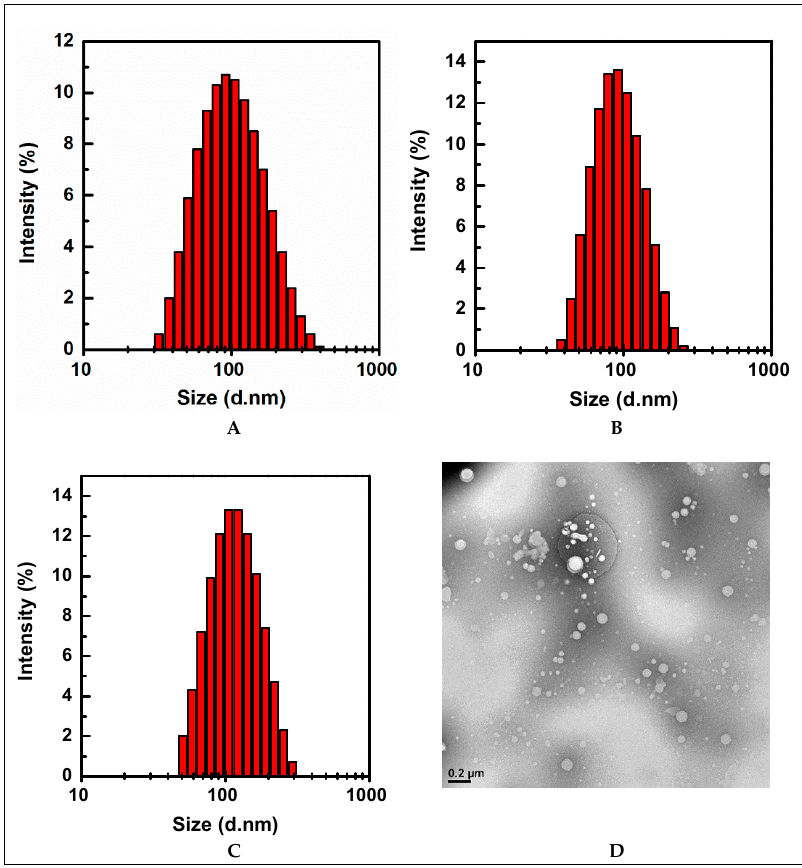
Table 4. Nanoparticles yield, sensitizer load, and entrapment efficiency obtained from nanoprecipitation using THF.